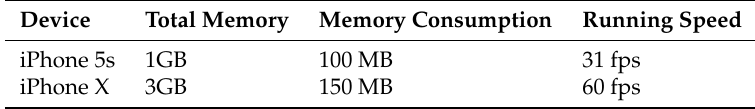
Table 5. Running speed and and memory consumption of our implemented mobile